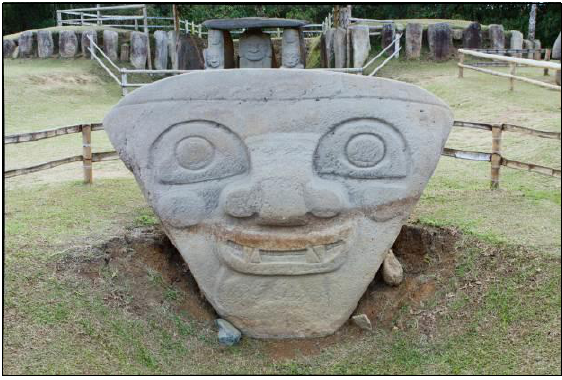
Figure 2. Photo of “Escultura 23“ showing the fence and the rear part still being covered by the terrain.